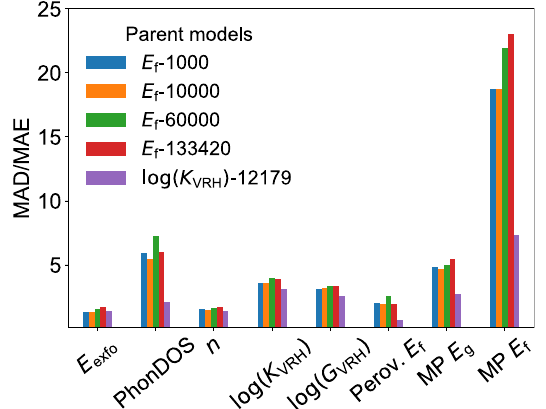
Fig. 5 The effects of changing the parent MEGNet models on the performances of the AtomSets- V 1 models. The y axis is the mean- absolute deviation (MAD) divided by the MAE. A higher value corresponds to a better